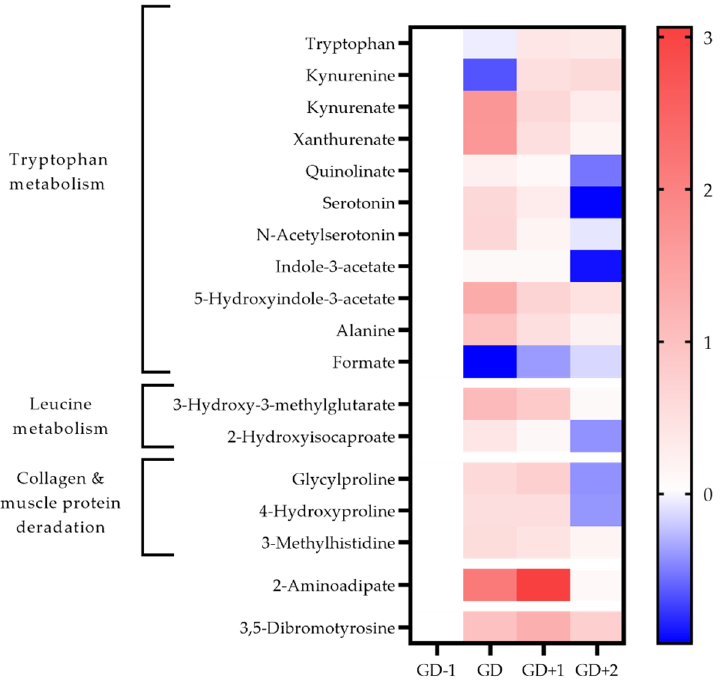
Figure 4. Heatmap of metabolites identified as key discriminators between timepoints via PLSDA modelling in urine samples. The fold change calculated from the GD − 1 sample is displayed as the natural logarithm to indicate an increase (greater than 0, red) or decreased (less than 0, blue).